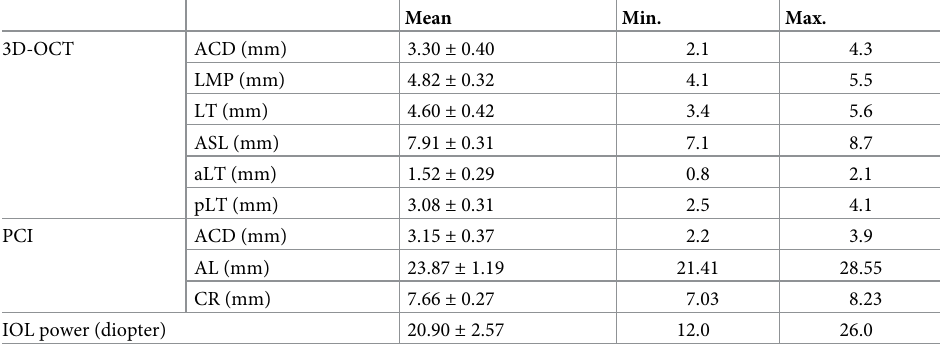
3D-OCT = 3-dimensional optical coherence tomography; ACD = anterior chamber depth; LMP = lens meridian parameter; LT = lens thickness; ASL = anterior segment length; aLT = anterior part of lens thickness; pLT = posterior part of lens thickness; PCI = partial coherence interferometry; AL = axial length; CR = corneal radius; IOL = intraocular